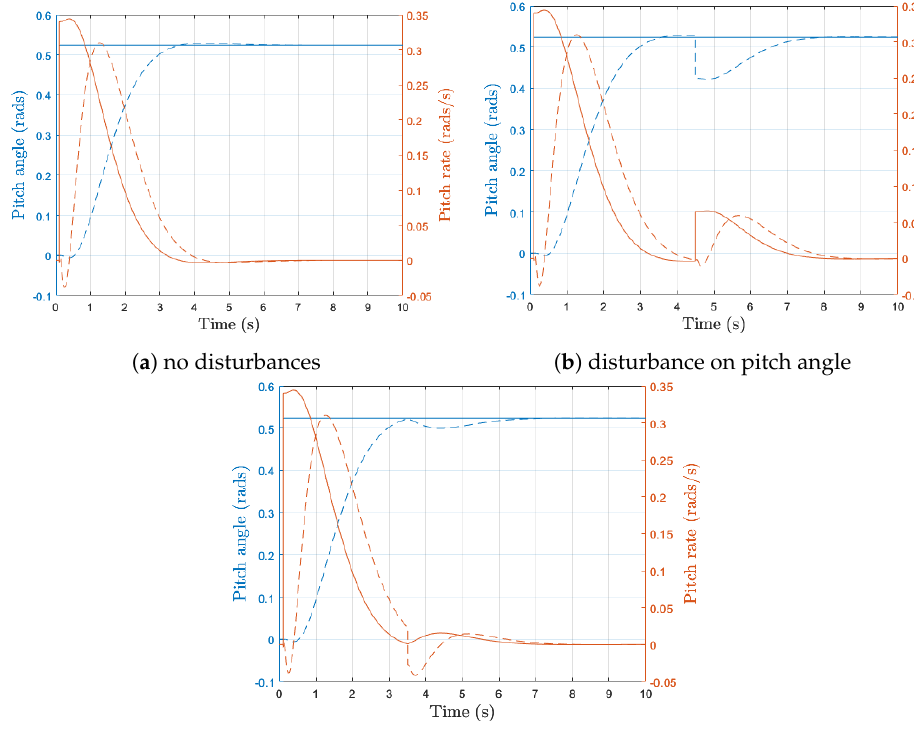
Figure 15. LS–i time domain